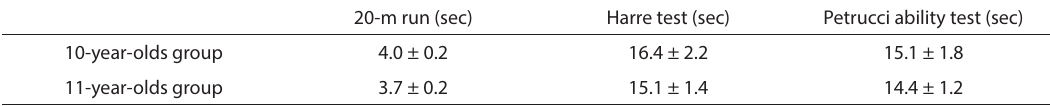
Table 1. Data related to the physical tests carried out on the four groups (mean ± standard deviation)